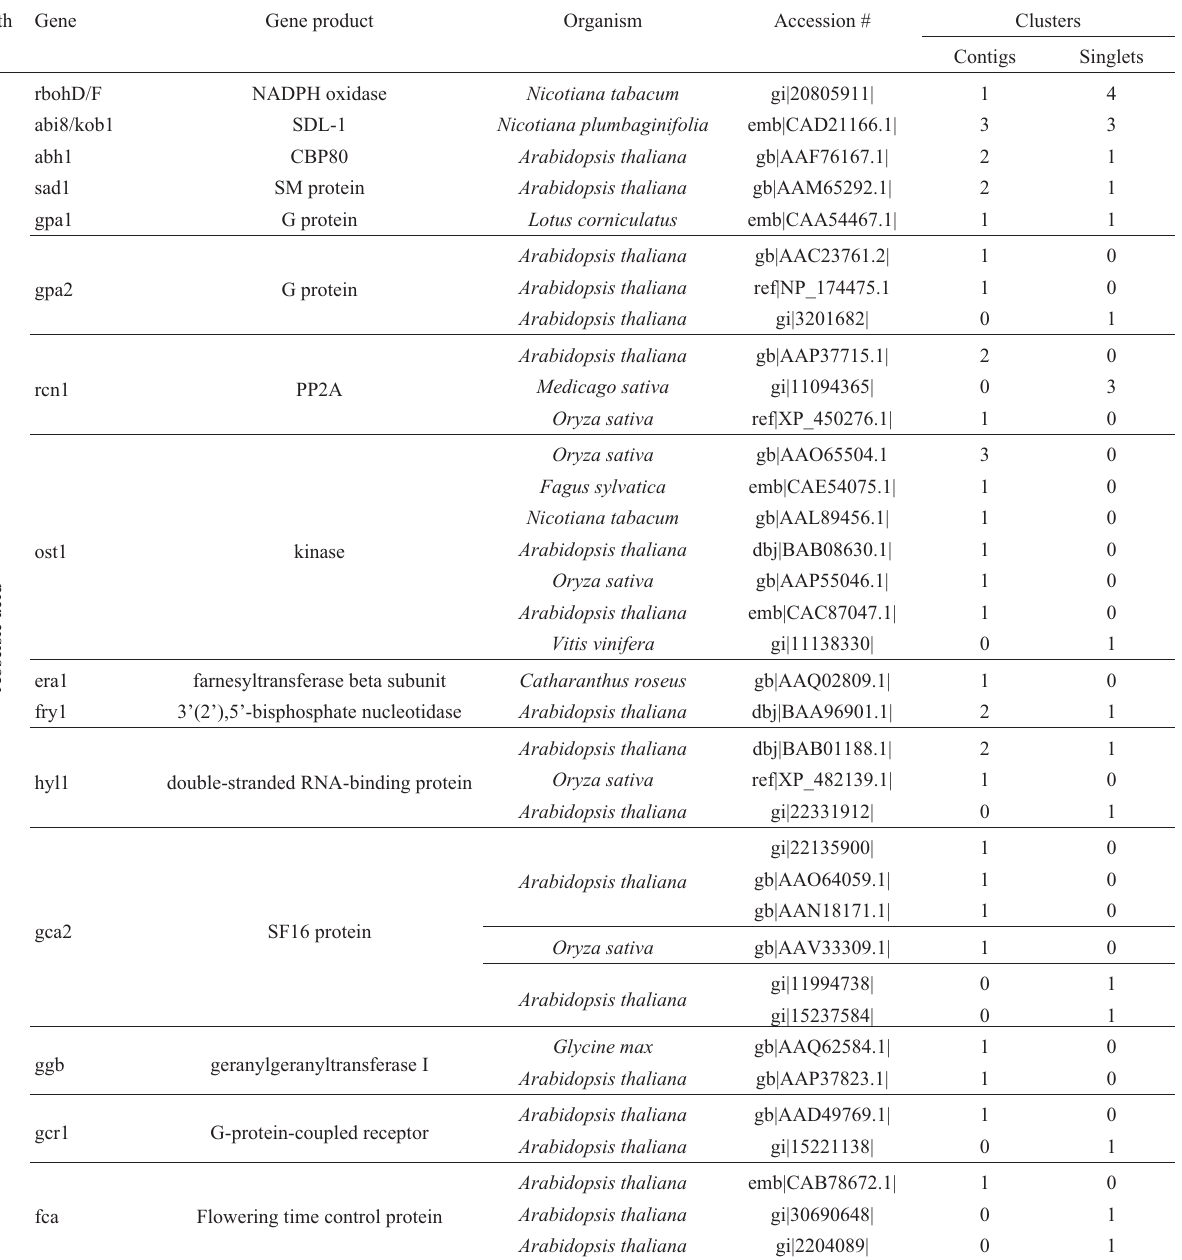
Table 4 - Ortholog genes of Abscisic acid signaling pathways found in the Citrus EST database. Path